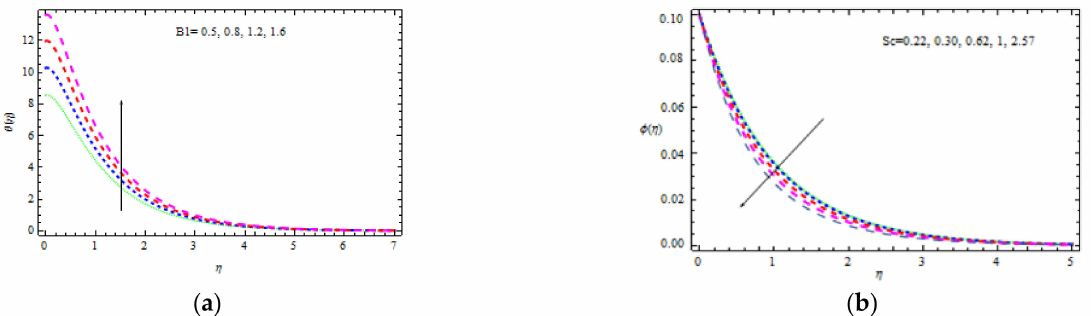
Figure 10. Inspiration of Bi 1 ( a ) and Ec , Rd ( b ) on